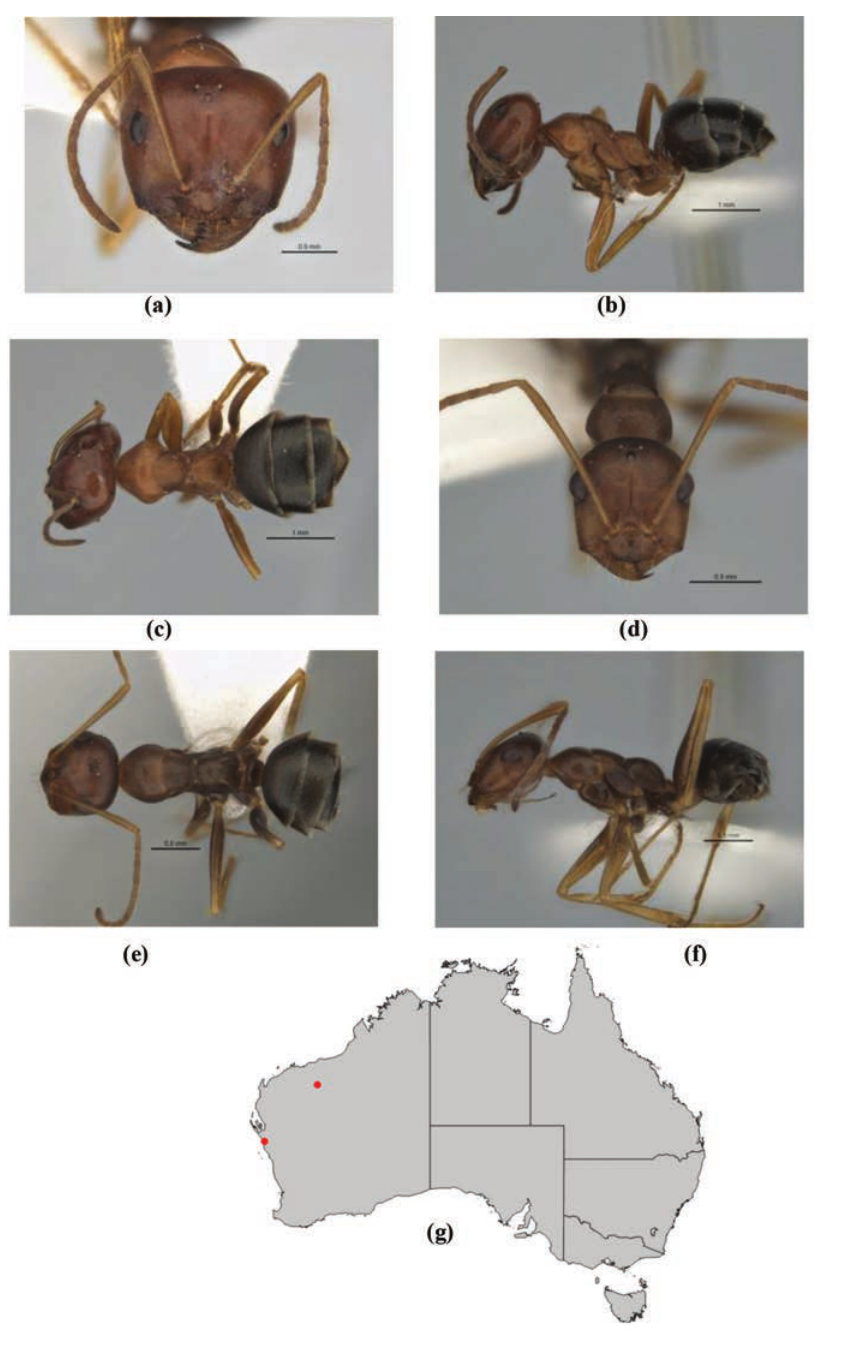
Figure 7. Melophorus attenuipes sp. n.: major worker paratype (JDM32-002000–top ant) frons ( a ), pro- file ( b ) and dorsum ( c ); minor worker holotype (JDM32-002000–bottom ant) frons ( d ), profile ( e ) and dorsum ( f ); distribution map for the species ( g ). Low resolution scale bars: 1 mm ( b, c ); 0.5 mm ( a, d–f